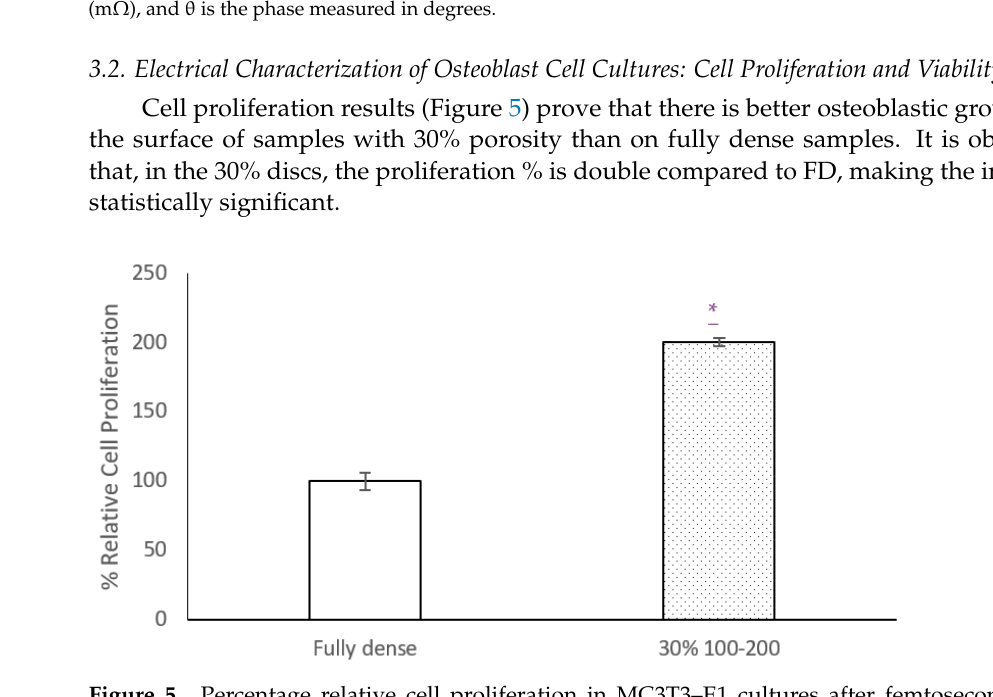
Figure 5. Percentage relative cell proliferation in MC3T3–E1 cultures after femtosecond laser treatment (by AlamarBlue). Results are represented vs fully dense growth. Significance level at p value < 0.05 (*).